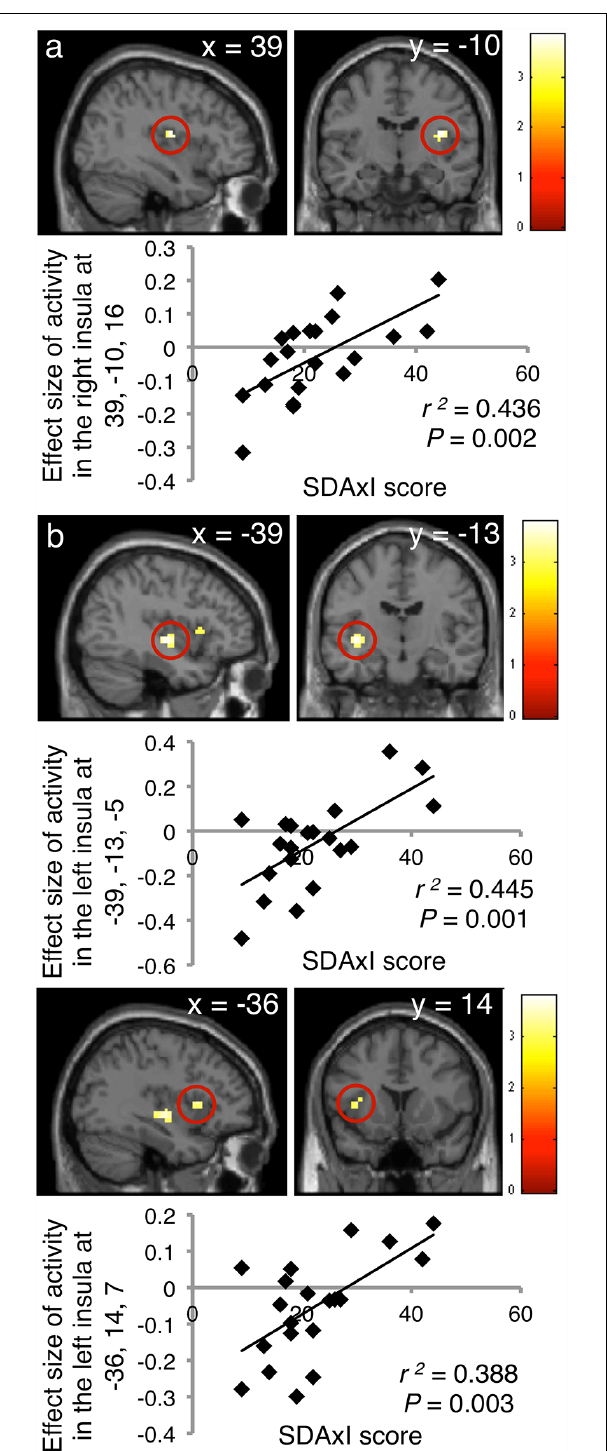
FIGURE 2 | Associations of brain responses to audiovisual footages of dental scaler or turbine with short version of Dental Anxiety Inventory (SDAxI) score ( n = 20). (A) Scaler video. Responses in the right insula were positively correlated with the SDAxI score. (B) Turbine video. Responses in the left insula (first peak, upper panel; second peak, lower panel) were positively correlated with the SDAxI